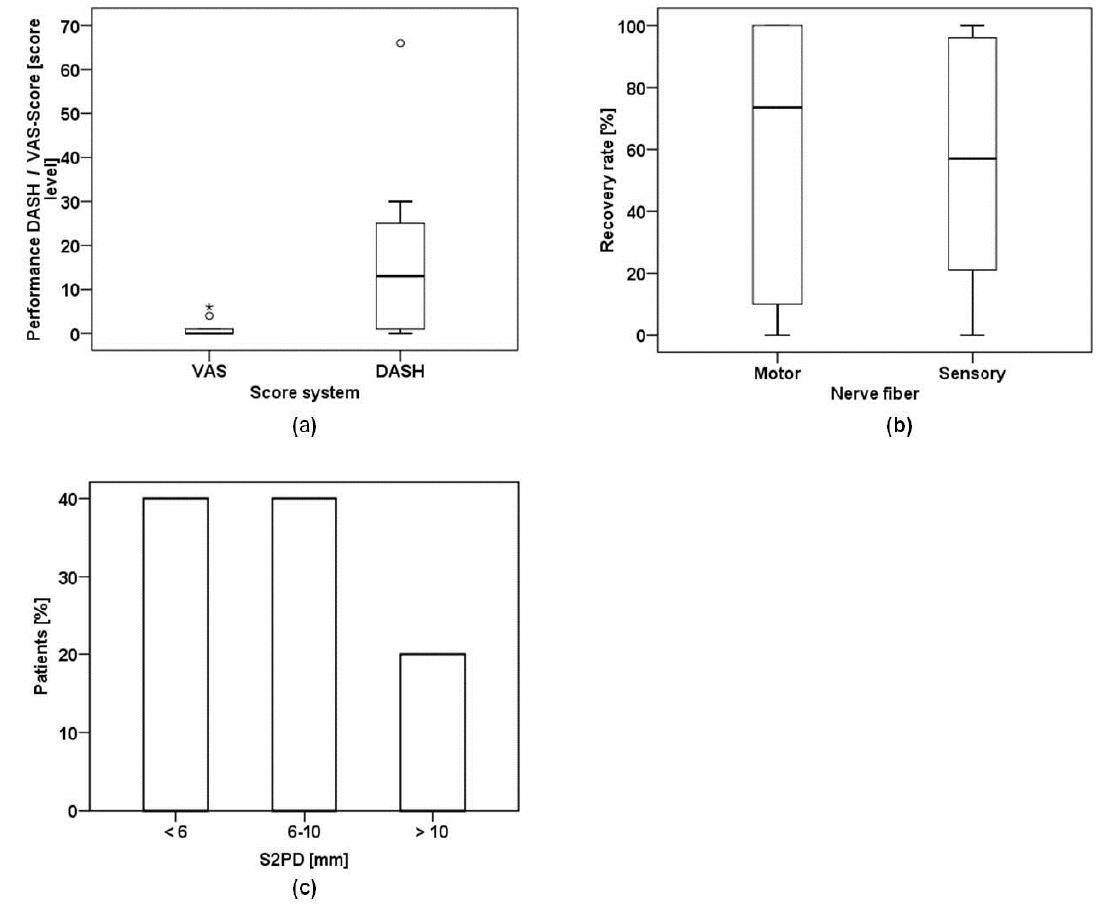
Figure 1. Outcome measurements after a mean follow up of 19.9 months post-surgery: ( a ) Median of DASH and VAS scores presented as box plots. The median DASH score was 13.0 with a mean of 17.0. The median in VAS scores was 0.0 with a mean of 1.1; ( b ) The box plot represents nerve function relative to the contralateral corresponding nerve. For motor function the median was 78.5%. For sensory function the median was 23.0%; ( c ) Bars represent percentage of patients with their corresponding results in the S2PD. Eighty percent of the patients reached less than 10 mm in the S2PD assessment.